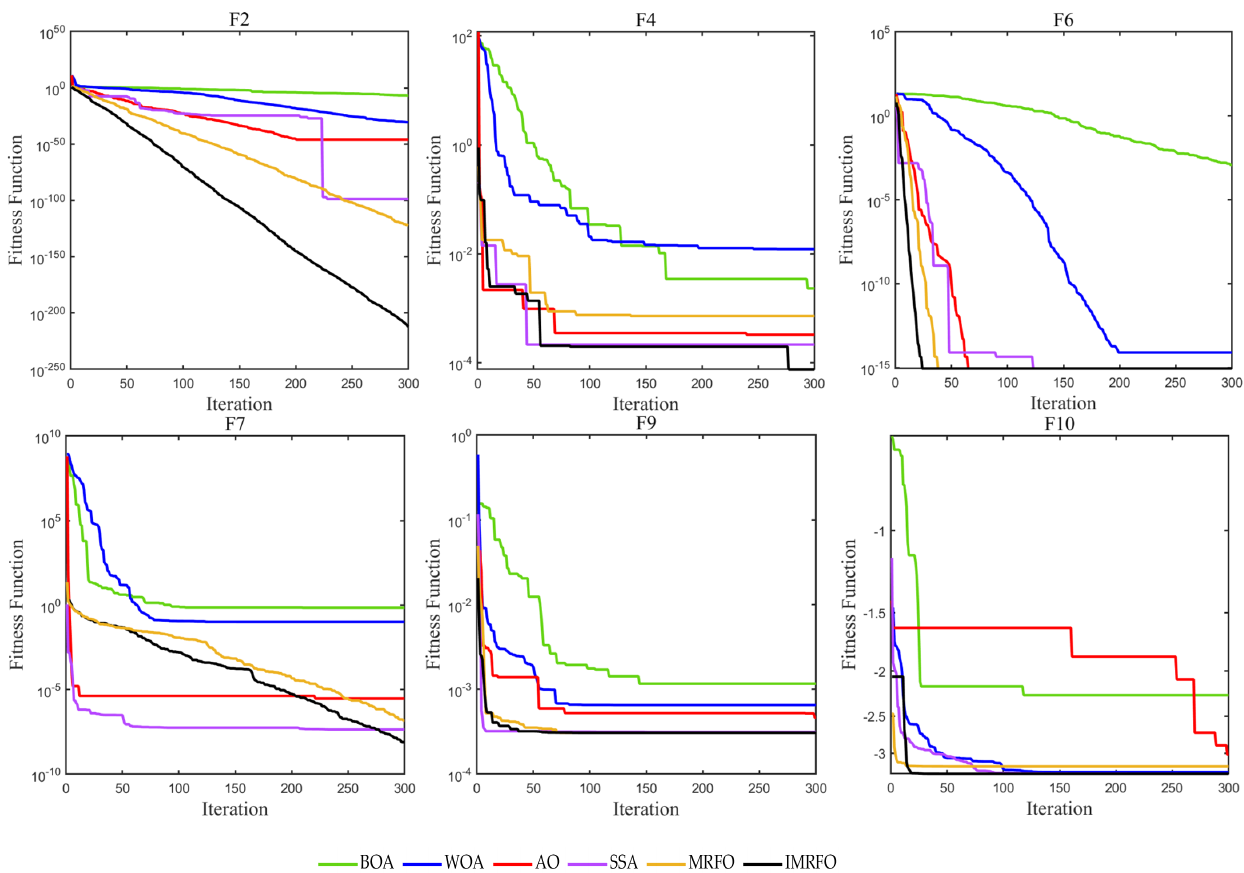
Figure 6. Convergence curve comparison chart.